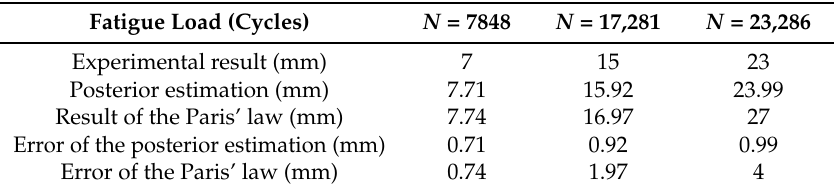
Table 3. The posterior estimation of the crack length for the specimen T 5 .